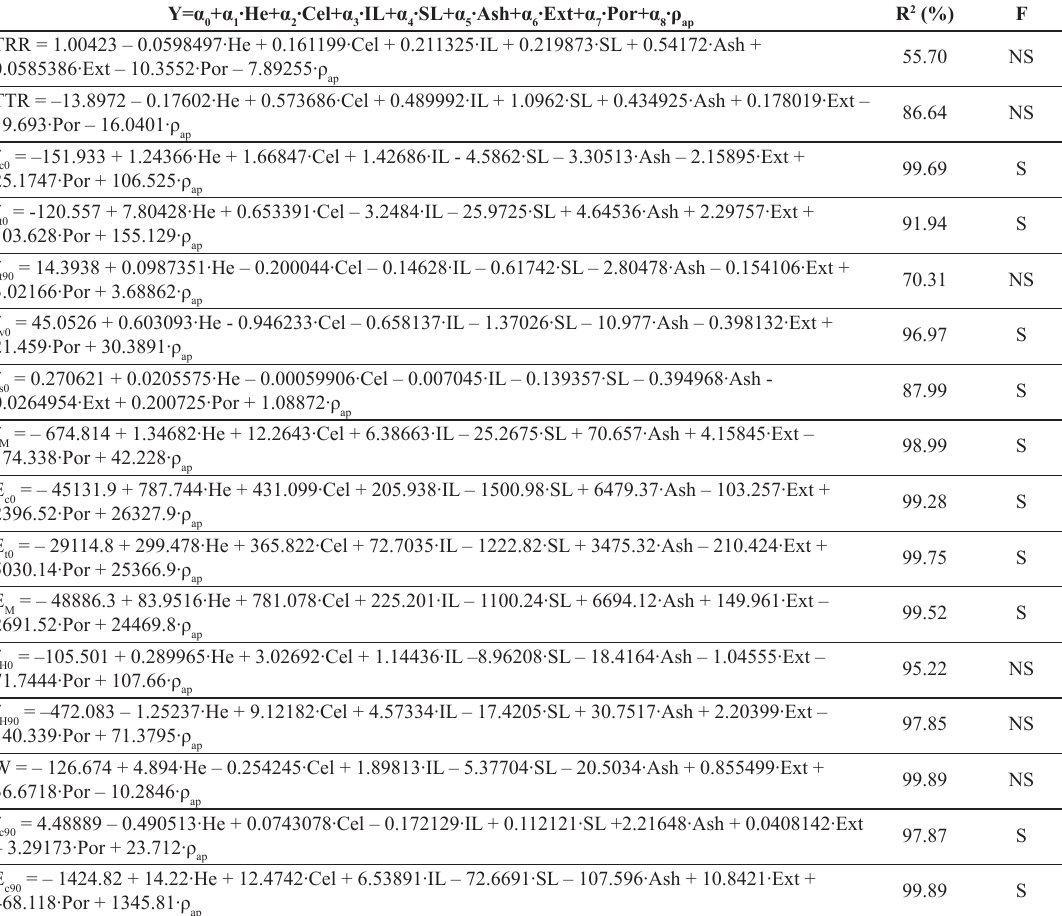
Table 3. Results of multivariable regression models applied for the ten wood species.